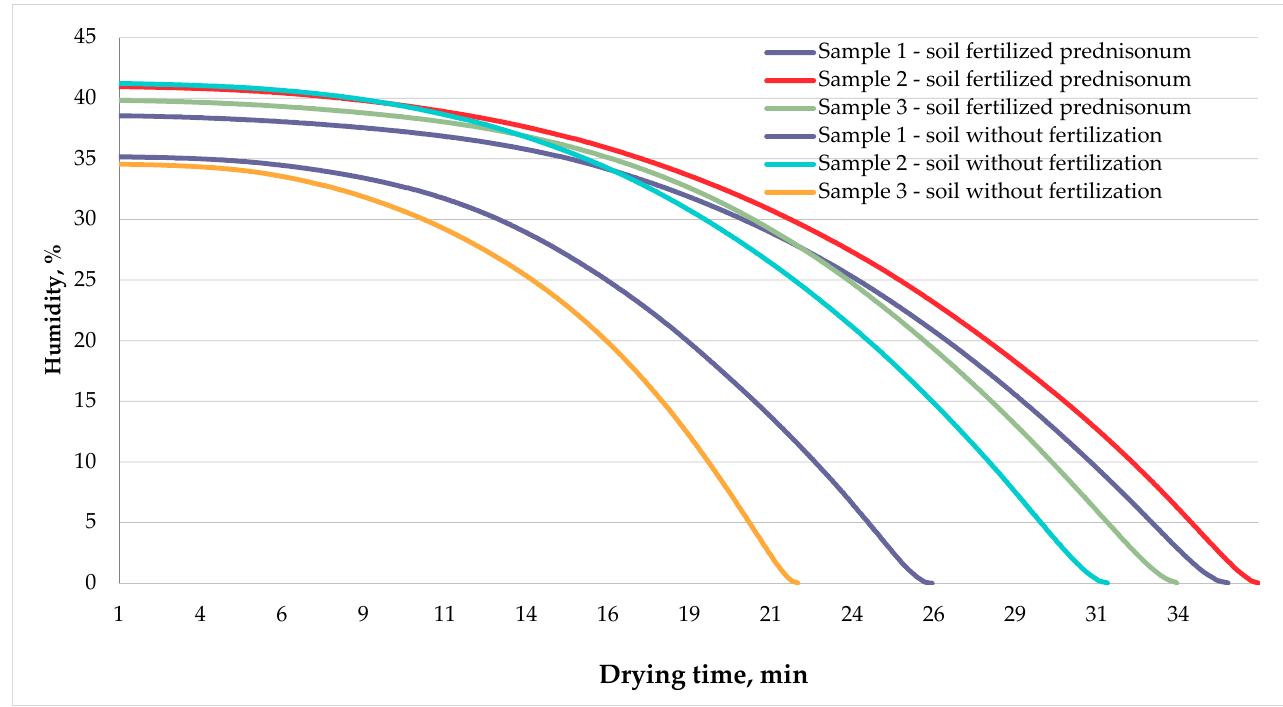
Figure 7. Soil drying curve under which the energy willow was grown.